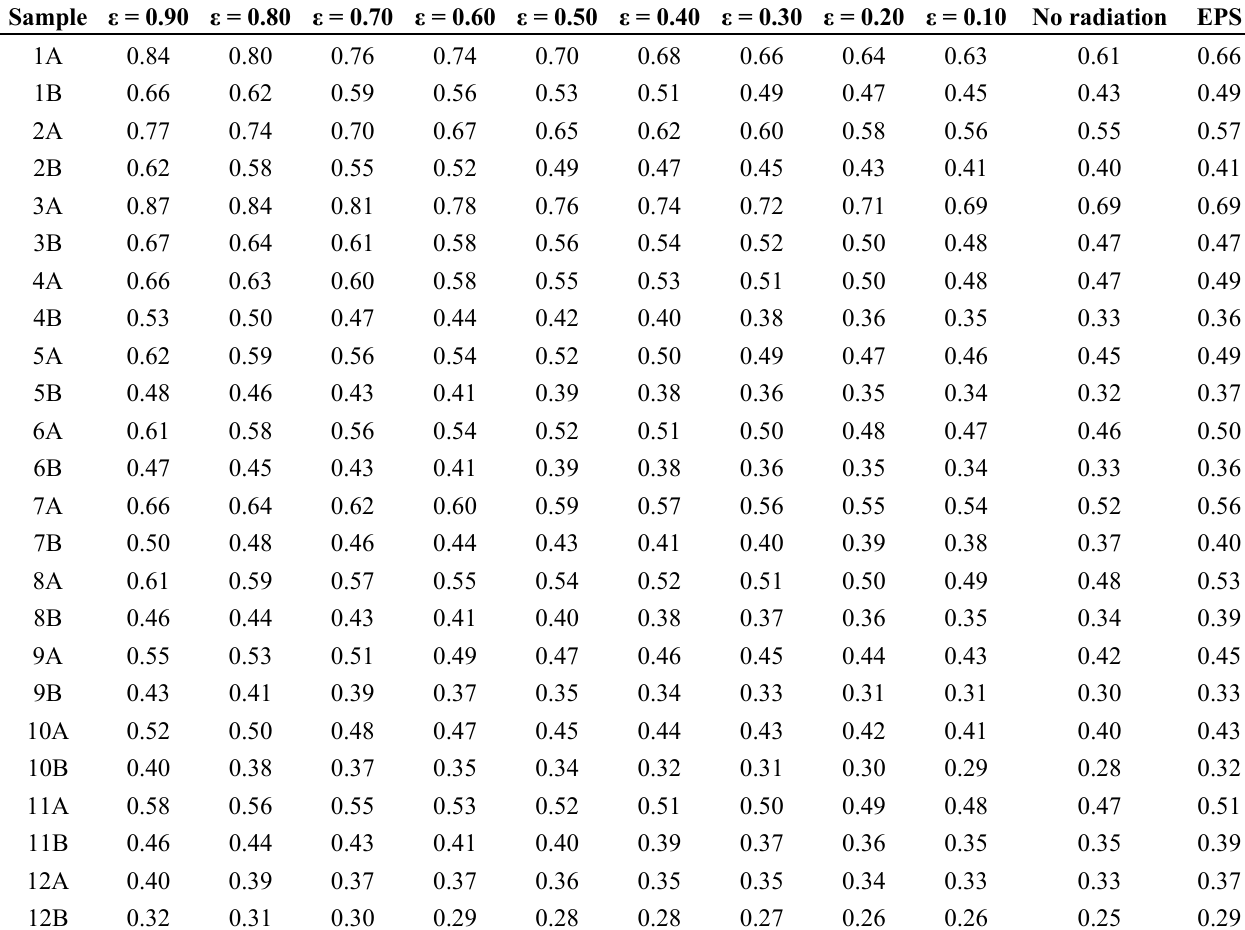
Table 8. Overall thermal transmittance of the wall built with the evaluated block (W/m 2